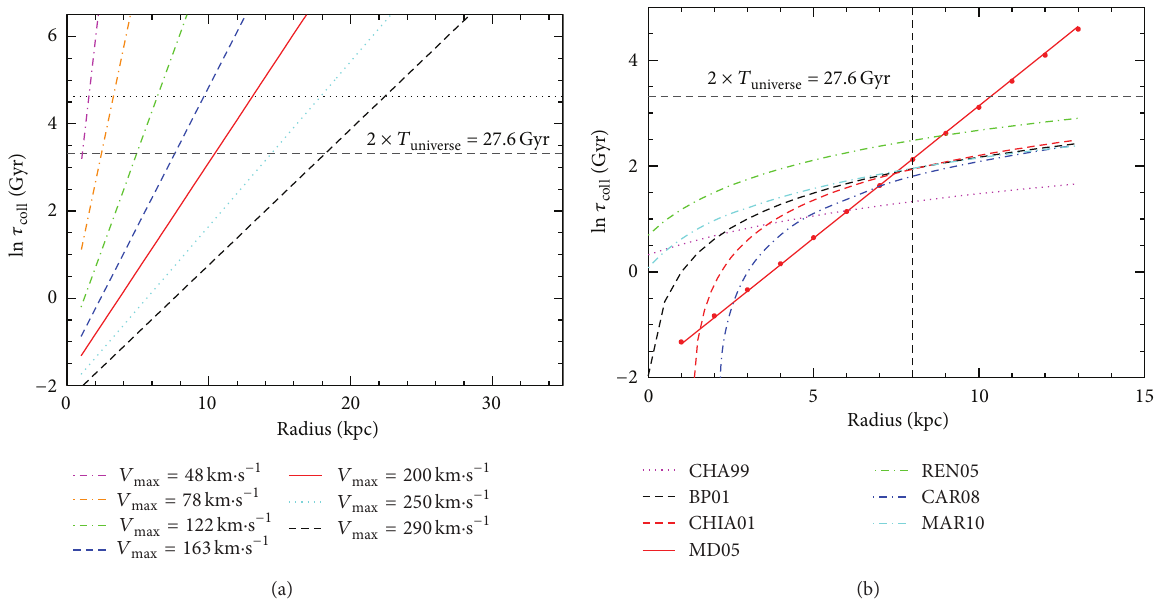
Figure 1: (a) Dependence of the collapse time scale, 𝜏 , in natural logarithmic scale, (in Gyr) on the galactocentric radius, Radius, in kpc. coll Each line represents a given maximum rotation velocity, 𝑉 max , or radial mass distribution as labeled. The dashed (gray) and dotted (black) = 13.8 Gyr. (b) Comparison of the radial lines show the time corresponding to 2 and 5 times, respectively, the age of the Universe, 𝑇 UNIVERSE , in natural logarithmic scale, for our MWG model, corresponding to 𝑉 max = 200 km s −1 , shown dependence of the collapse time scale, 𝜏 coll by the solid red line, with the radial functions used by Chang et al. [73], Boissier and Prantzos [32], Chiappini et al. [74], Renda et al. [75], Carigi and Peimbert [76], and Marcon-Uchida et al. [35] labeled CHA99, BP99, CHIA01, REN05, CAR08, and MAR10,